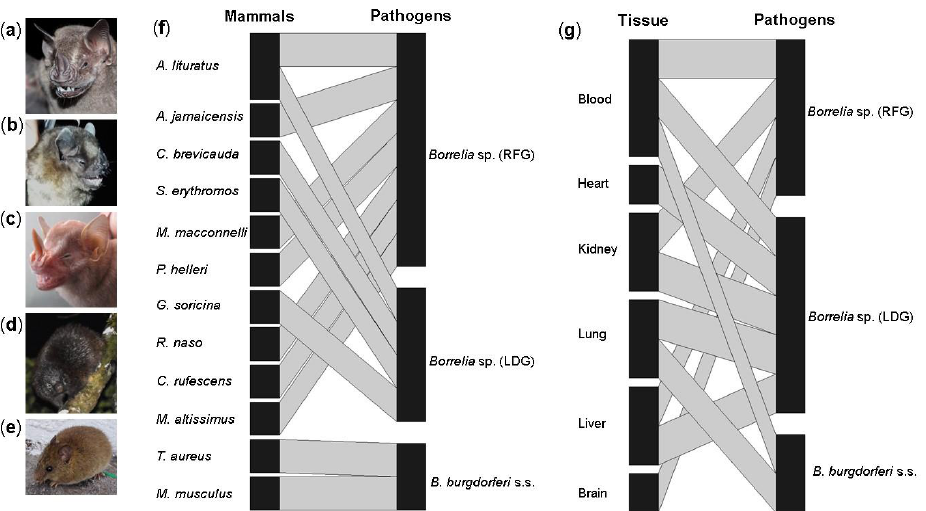
Figure 4. Association networks: ( a ) Artibeus lituratus , ( b ) Sturnira erythromos , ( c ) Platyrrhinus helleri , ( d ) Coendou rufescens , ( e ) Microryzomys altissimus ; ( f ) associations between wild mammals and Borrelia species in the department of Caldas; ( g ) associations between wild mammal tissues and the Borrelia species